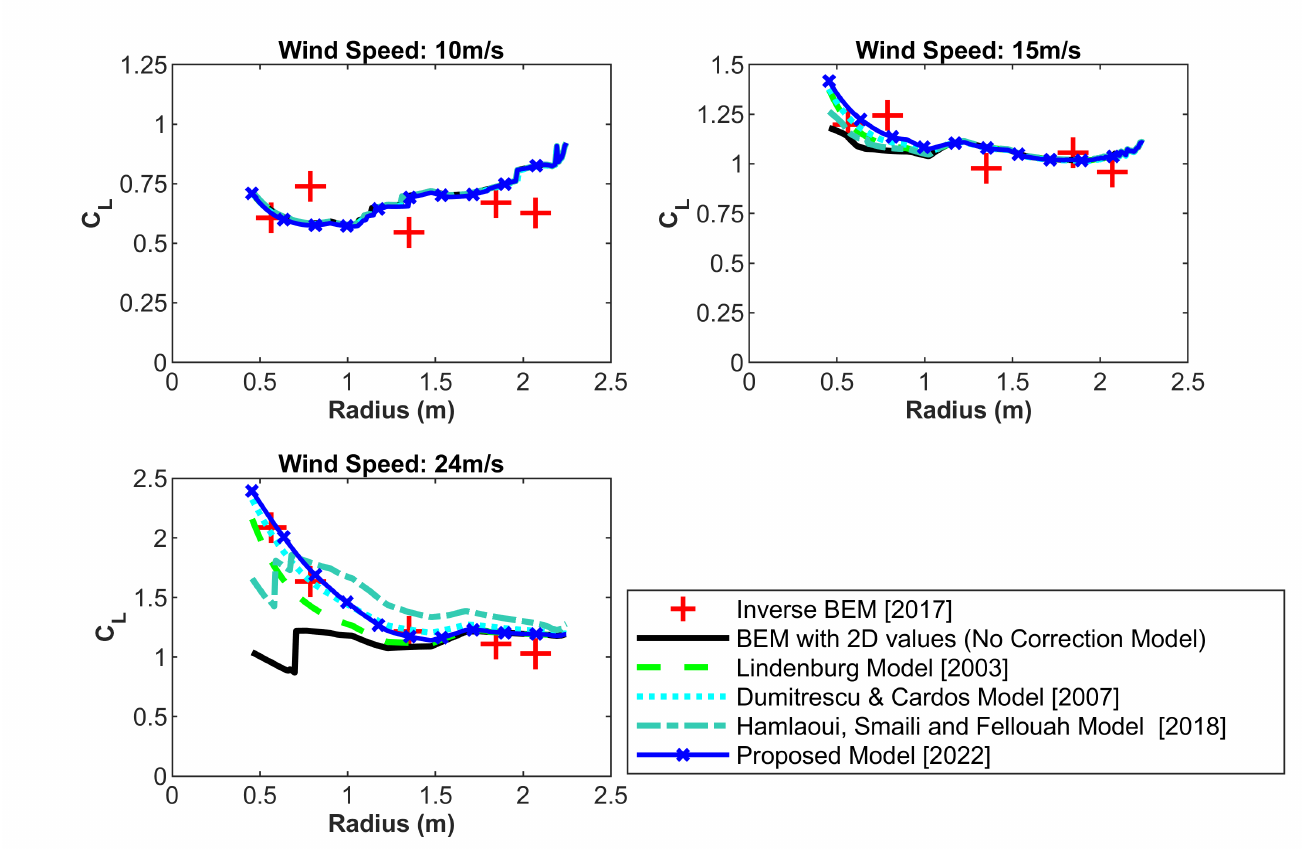
Figure 10. Contrast of evaluated C L throughout the blade length from BEM analysis without and with different correction models for stall delay and Inverse BEM method for MEXICO rotor.